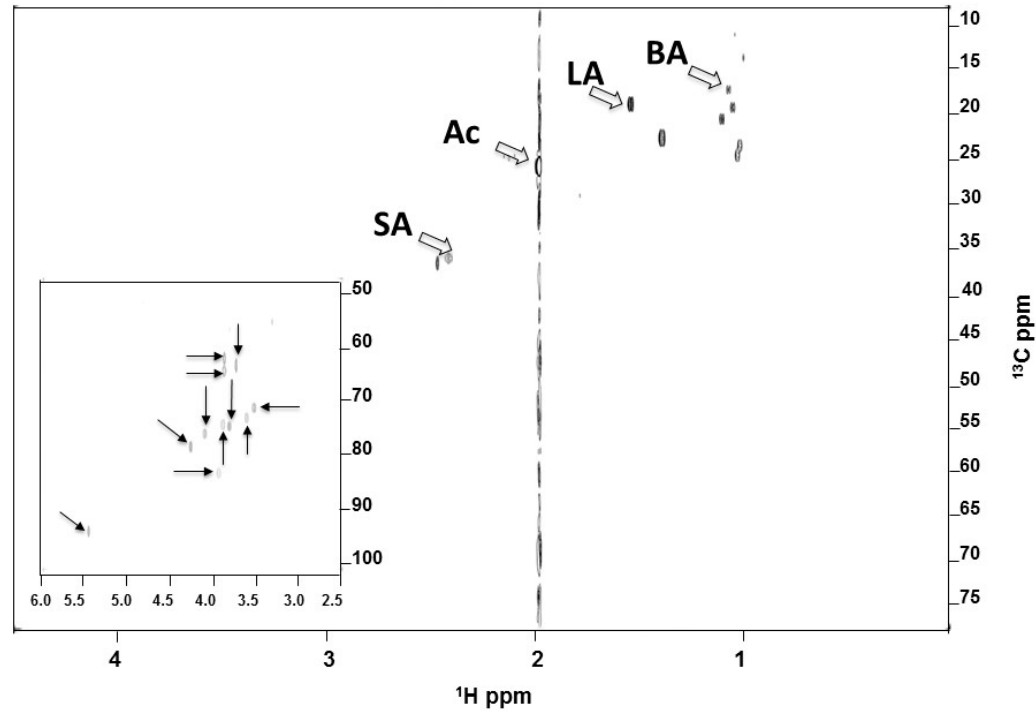
Figure 3. Short-chain fatty acid (SCFA) identification by NMR analysis. The media of S. epidermidis 13 C 12 -sucrose fermentation were centrifuged and passed through a 0.2 μ m filter. Supernatants were then mixed with 10% D 2 O and analyzed by NMR spectrometers. A 2-D 1 H- 13 C HSQC NMR spectrum (600 MHz) was displayed. The un-metabolized 13 C 12 -sucrose (solid arrows) appears 2.5–6.0 and 50–100 ppm in the 1 H- and 13 C-NMR spectra, respectively. Besides sucrose, four SCFAs (acetic (Ac), butyric (BA), lactic (LA), and succinic acids (SA), open arrows) were detected in the ferments of S. epidermidis .